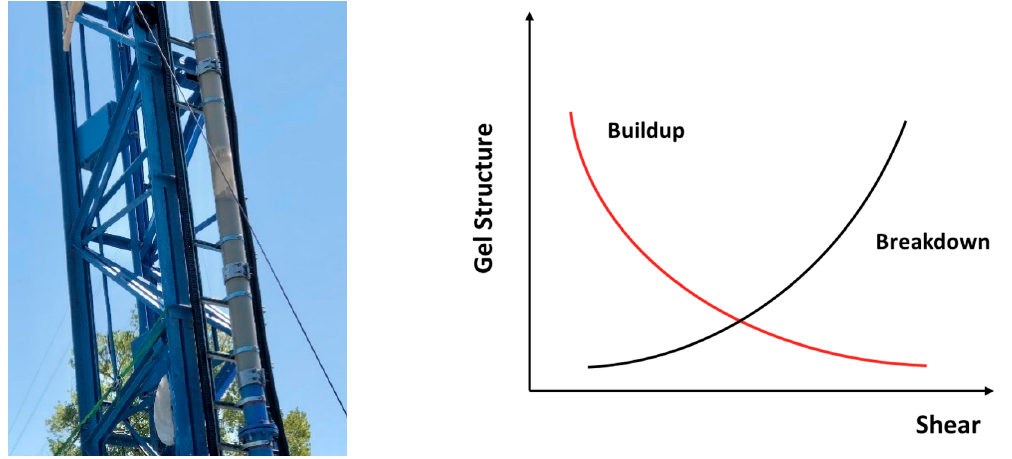
Figure 21. Gel strength caused a stagnant Taylor bubble in 48.5 lb/bbl BW at 4°.